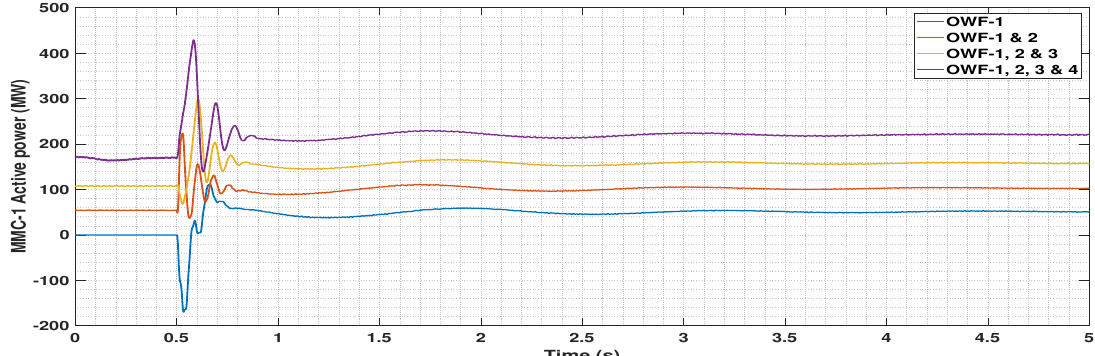
Figure 22. Active power in MMC-1 bus upon connecting all OWFs with 50 MW generation each.